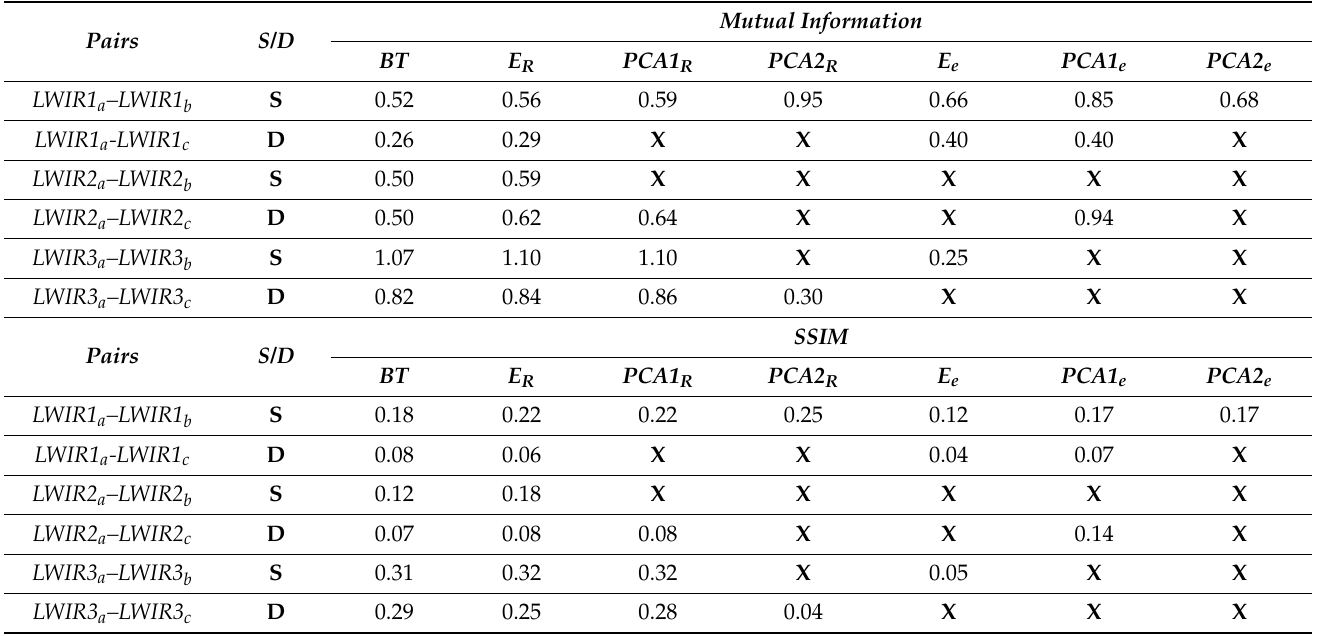
Table 5. Mutual information and SSIM results after the registration for different 2D maps for the images captured on the same (S) and different (D) days. “ X ” indicates the cases where there is not a sufficient number of matches to estimate the geometric transform between the images. ( BT : brightness temperature estimate, E R : average energy of radiance spectrum, PCA1 R : 1st PCA component of radiance spectra, PCA2 R : 2nd PCA component of radiance spectra, E e :